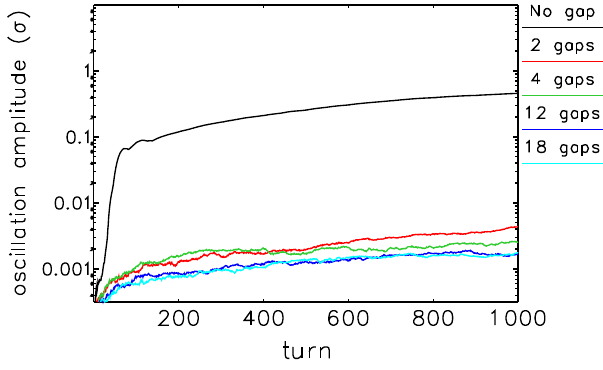
FIG. 21. Lifetime of unique bunches for the case of 12 two- bunch gaps, comparing simple and compensated gaps.